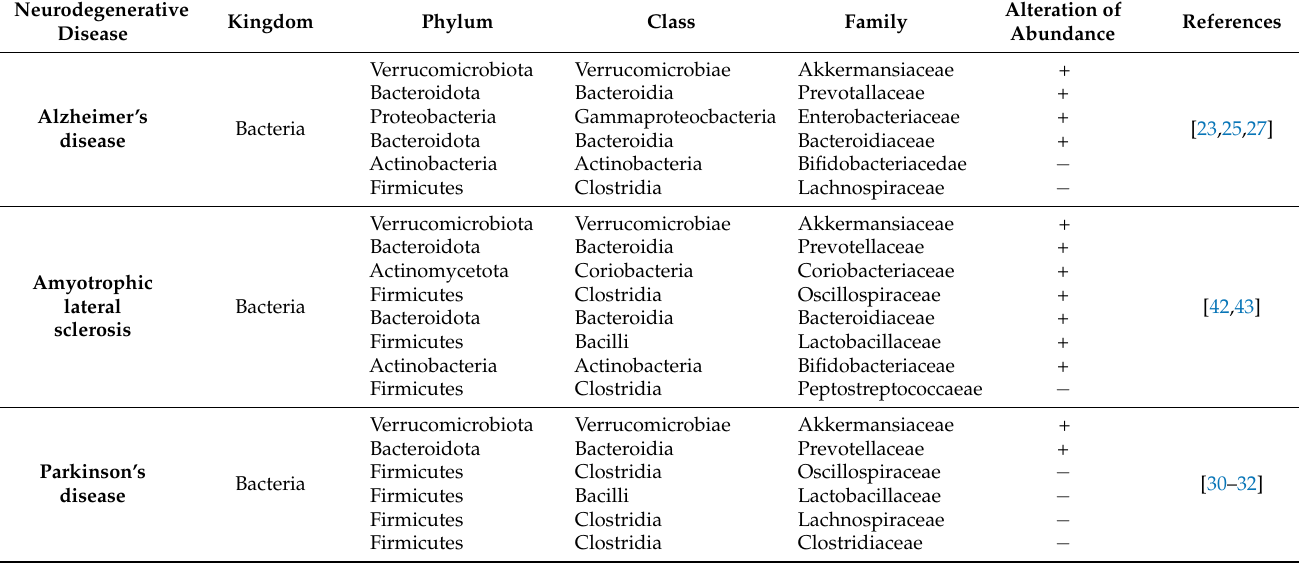
Table 1. Several bacterial and prokaryotic phyla are implicated in dysbiotic processes related to the onset of neurodegenerative diseases. The Akkermansiaceae and Prevotellaceae families are increased in Alzheimer’s, Parkinson’s, and ALS patients. Likewise, prokaryotic Bacteroidiaceae families are present in AD and ALS. In contrast, the Lachnospiraceae and Peptostreptococcaeae are respectively less numerous in these diseases. Opposite patterns of bacterial abundance were found in the Bifidobacteriaceae families between AD and ALS; in the Oscillospiraceae, and in Lactobacillaceae between PD and ALS [23,30,42].